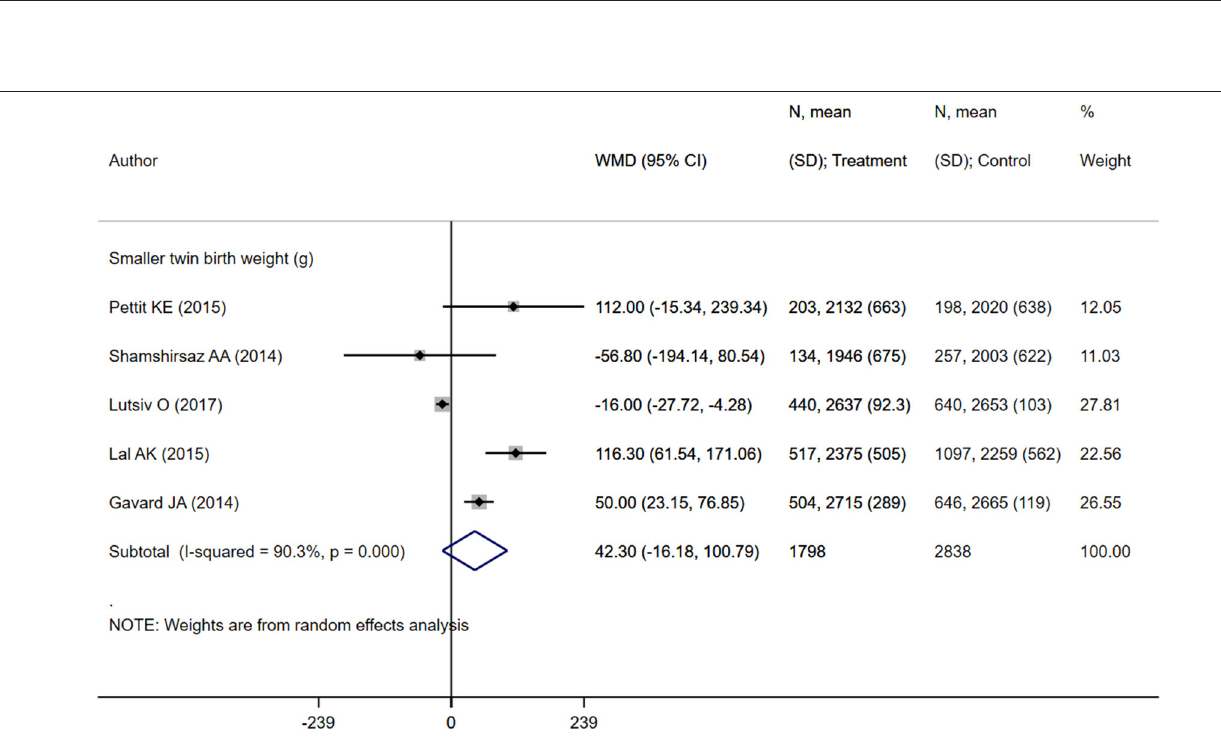
Frontiers in Pediatrics |